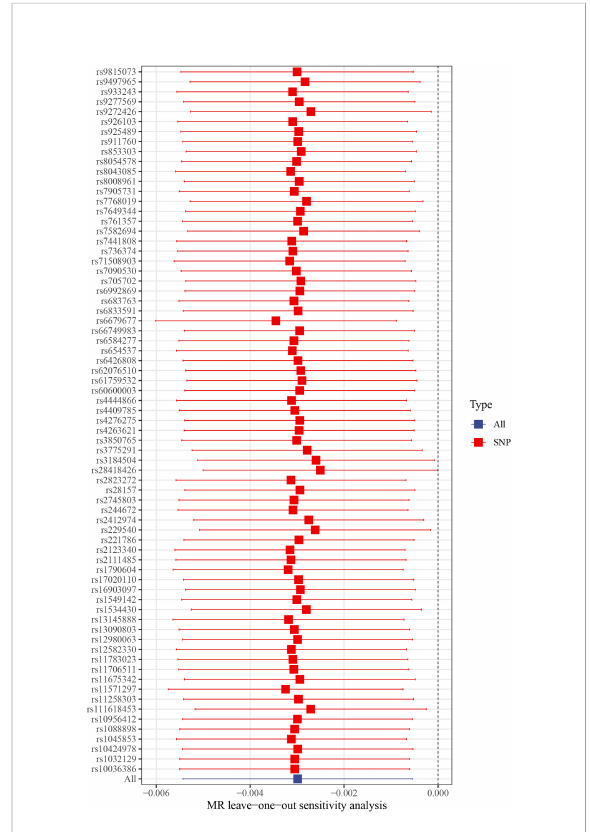
FIGURE 6 Leave-one-out plots of hypothyroidism with the risk of HCC. Leave-one-out analysis for IVW MR of hypothyroidism on HCC in summary-level analyses. SNP, single-nucleotide polymorphism; HCC, Hepatocellular carcinoma; MR, Mendelian randomization.